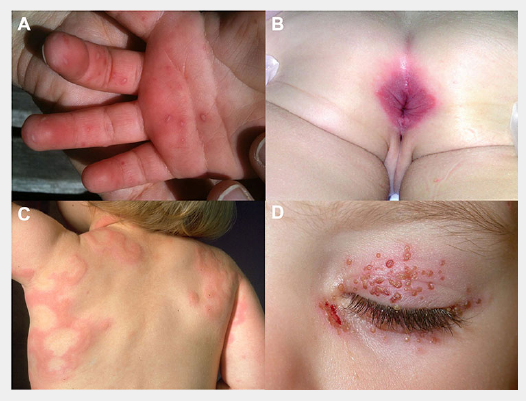
Clinical examples of skin disorders which were commonly encountered in the Pediatric Emergency Department. 1A. Hand- foot-mouth disease. 1B. Perianal streptococcal infection. 1C. Anular urticaria of childhood. 1D. Periocular herpes simplex virus